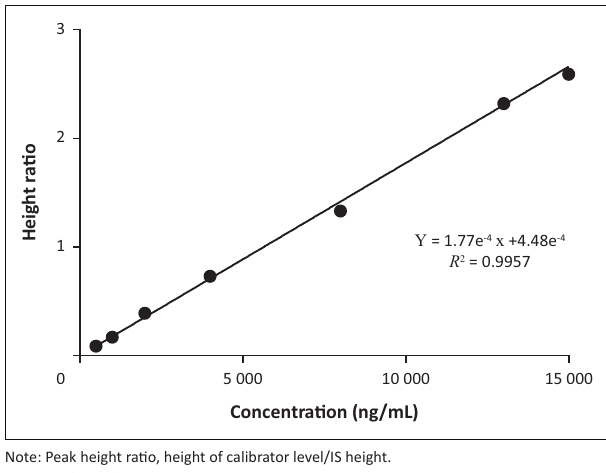
FIGURE 1: Chromatograms of blank plasma (a) and blank plasma spiked with internal standard and nevirapine (b) showing no endogenous components interference at nevirapine and internal standard retention